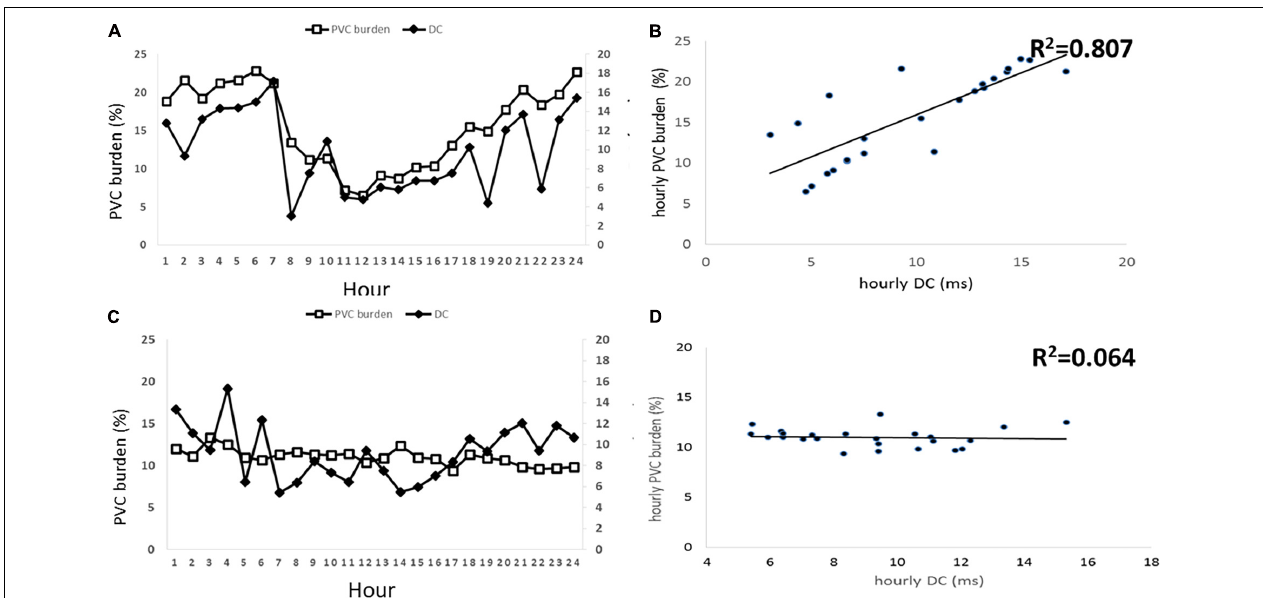
FIGURE 1 | Associations between hourly premature ventricular contractions (PVCs) burden in % and hourly deceleration capacity (DC) in ms. The left two panels (A,B) illustrate this association in patients with PVCs dependent on DC and the right two panels illustrate the association in DC independent PVCs patients. (A) shows hourly PVCs burden and hourly DC plotted over 24 h in D-PVCs patients. (B) shows correlation between hourly PVCs burden and hourly DC in D-PVC patients. (C) shows hourly PVCs burden and hourly DC plotted over 24 h in I-PVC patients. (D) shows correlation between hourly PVCs burden and hourly DC in I-PVC